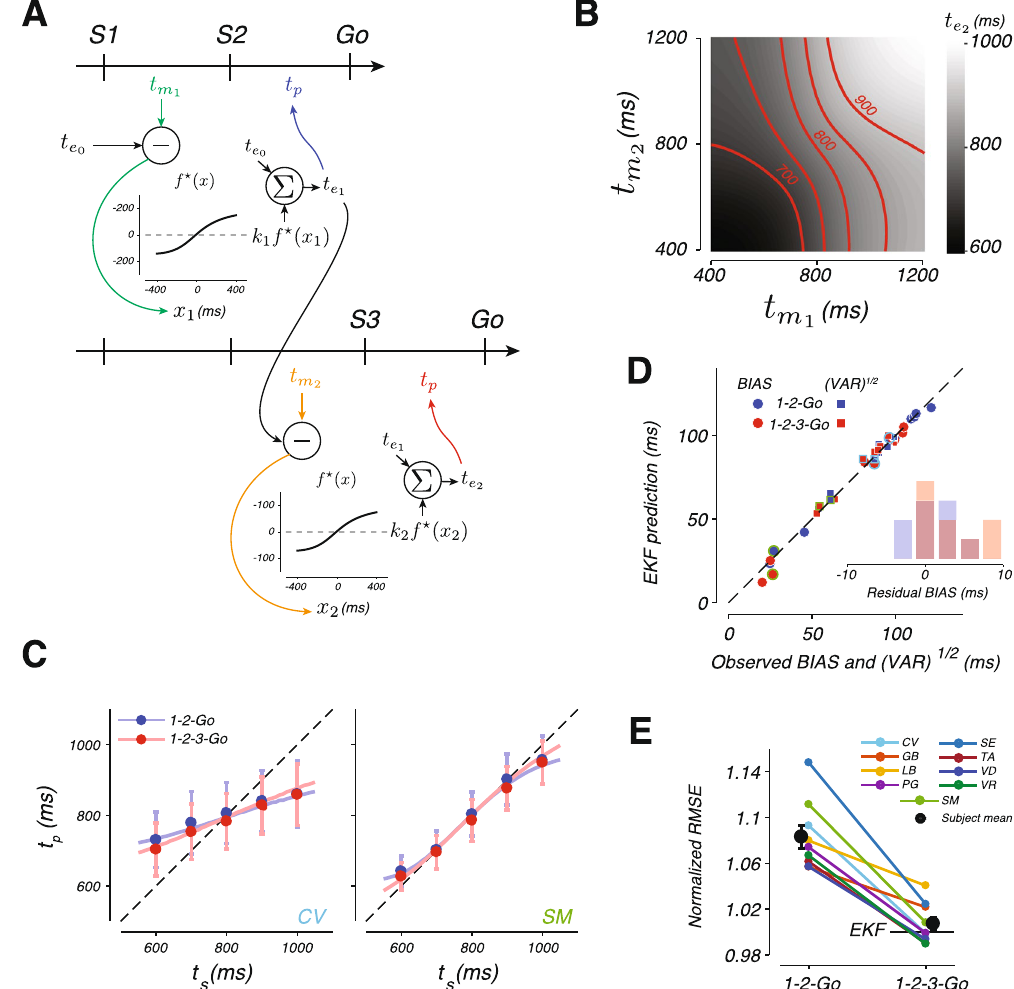
Figure 6. An extended Kalman filter (EKF) model and its fits to the data. ( A ) EKF algorithm. EKF is a real-time inference algorithm that uses each measurement to update the estimate. After the first flash, EKF uses the mean of the prior as its initial estimate, t . The second flash furnishes the first measurement, t . EKF computes a new e 0 m 1 estimate, t , using the following procedure: (1) it measures the difference between t and t to compute an e 1 m 1 e 0  by a gain factor, k error, x 1 , (2) it applies a nonlinear function, f x ( )  , to x 1 , (3) it scales f x ( ) 1 , whose magnitude 1 depends on the relative reliability of t and t , and (4) it adds  k f x ( ) to t to compute t . In the 1-2-Go 1 1 m 1 e 0 e 0 e 1 condition (top), t is the final estimate used for the production of t p . In the 1-2-3-Go condition (bottom), the e 1 updating procedure is repeated to compute a new estimate t by adding t to  k f x ( ) where x 2 is the difference 2 2 e 2 e 1 between the second measurement, t , and t , and k 2 is the scale factor determined by the relative reliability of t m 2 e 1 e 1 and t . t is then used as the final estimate for the production of t p . We assumed that the produced interval, t p , is m 2 e 2 perturbed by zero-mean Gaussian noise with standard deviation proportional to the final estimate ( t for 1-2- e 1 Go and t for 1-2-3-Go) with the constant of proportionality w p , as in the BLS model. ( B ) The mapping from e 2 measurements to estimates (grayscale) for the EKF estimator in the 1-2-3-Go condition. Red lines indicate = 700, 750, 800, 850, and 900 ms). combinations of measurements that lead to identical estimates (shown for t e 2 ( C ) Mean and standard deviation of t p as a function of t s for two example subjects (circles and error bars) along with the corresponding fits of the EKF model (lines). ( D ) BIAS (circles) and VAR (squares) of each subject (abscissa) and the corresponding values computed from simulations of the fitted EKF model (ordinate). Conventions match Fig. 4B. ( E ) The RMSE in the 1-2-Go and 1-2-3-Go conditions relative to the corresponding predictions from the EKF model (conventions as in Fig. 4C). See also Supplementary Figs 2, 3, 9, and